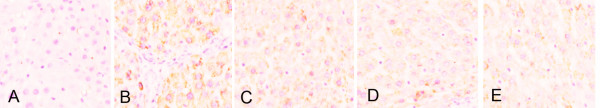
Immunohistochemical staining of GST-p. Control liver tissue: with weakly positive GST-p; Model liver tissue: with strongly positive GST-p expression. 1%, 2%, and 4%betaine groups showed liver tissues with positive GST-p expression. Original magnification: 10 × 40. A: Control; B: Model; C: 1% betaine; D: 2% betaine; E: 4% betaine.